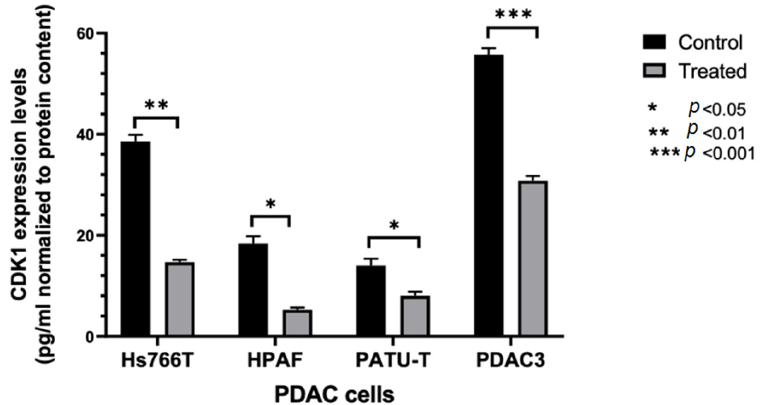
Figure 2. ELISA-based quantitation of CDK1 expression in PDAC cells following a 24 h exposure to DMSO (control) or to 10 µM of compound 6b . CDK1 expression was quantified using Human cyclin-dependent kinase 1 (CDK1) ELISA Kit according to the manufacturer’s instructions. Columns: mean; bars: SEM ( n = 3). *: p < 0.05, **: p < 0.01, ***: p < 0.001, significantly different compared with